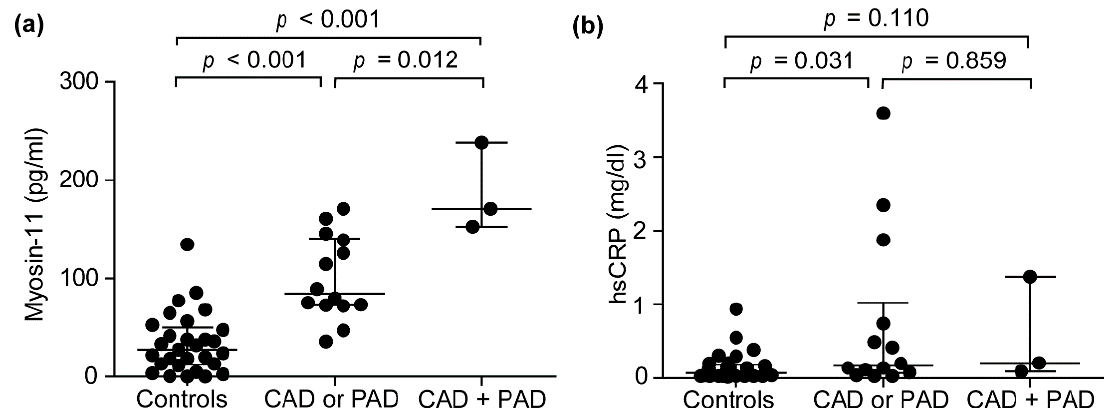
Figure 2. Plasma myosin-11 (myosin heavy chain 11) levels in subjects without renal insufficiency. ( a , b ) Myosin-11 and hsCRP (high-sensitivity C-reactive protein) concentrations in plasma samples of control subjects (Controls, n = 29), patients with CAD (coronary artery disease) or PAD (peripheral artery disease) (CAD or PAD, n = 14), and patients with both CAD and PAD (CAD + PAD, n = 3). Data are shown as the median with interquartile